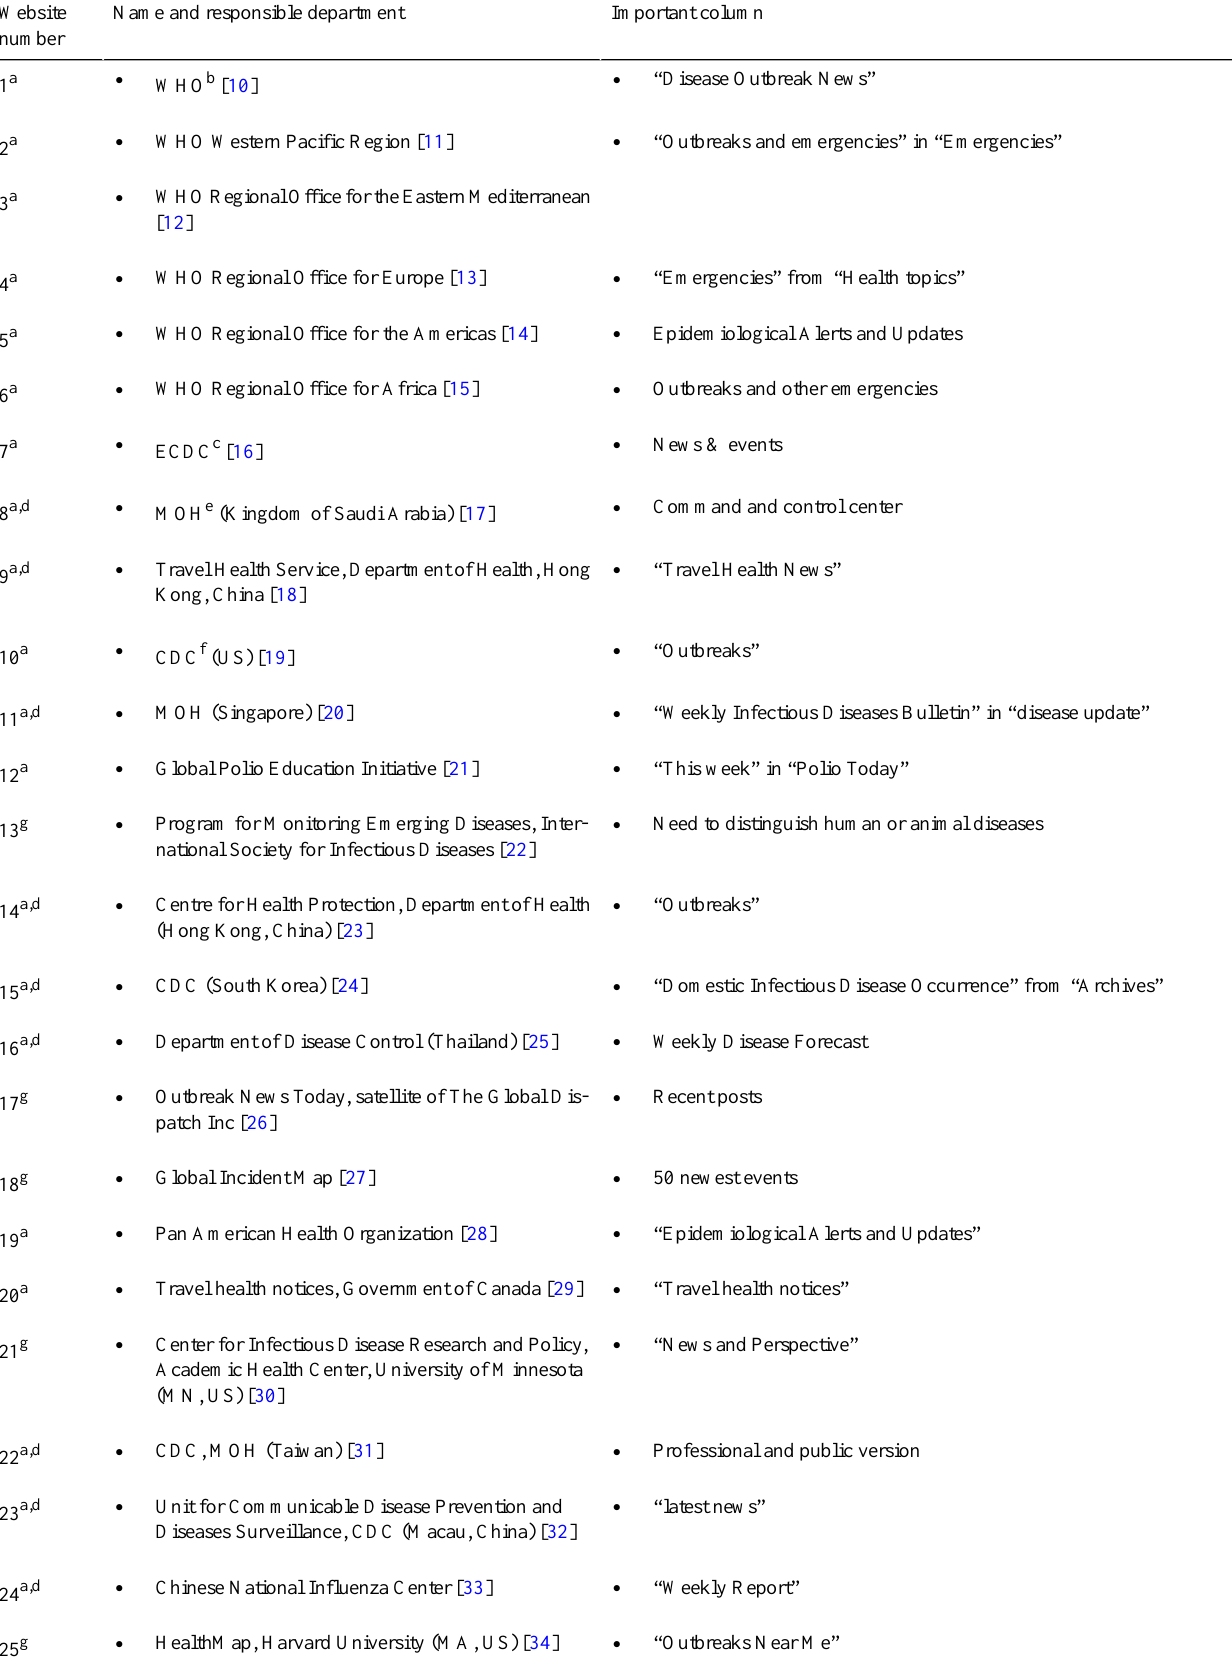
Table 1. Websites used in the Global Infectious Diseases Epidemic Information Monitoring